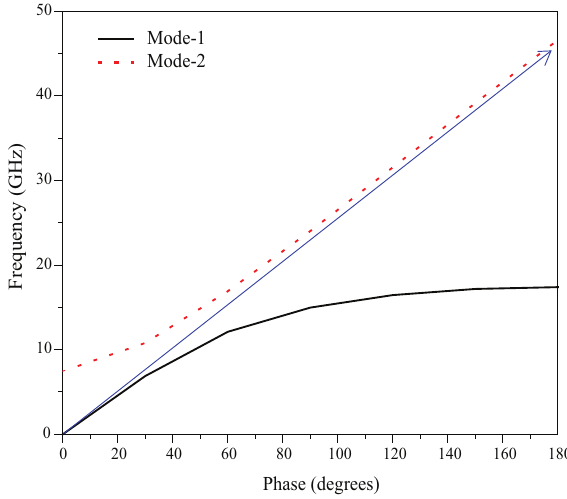
Figure 2. Dispersion curve for the proposed SSP Unit